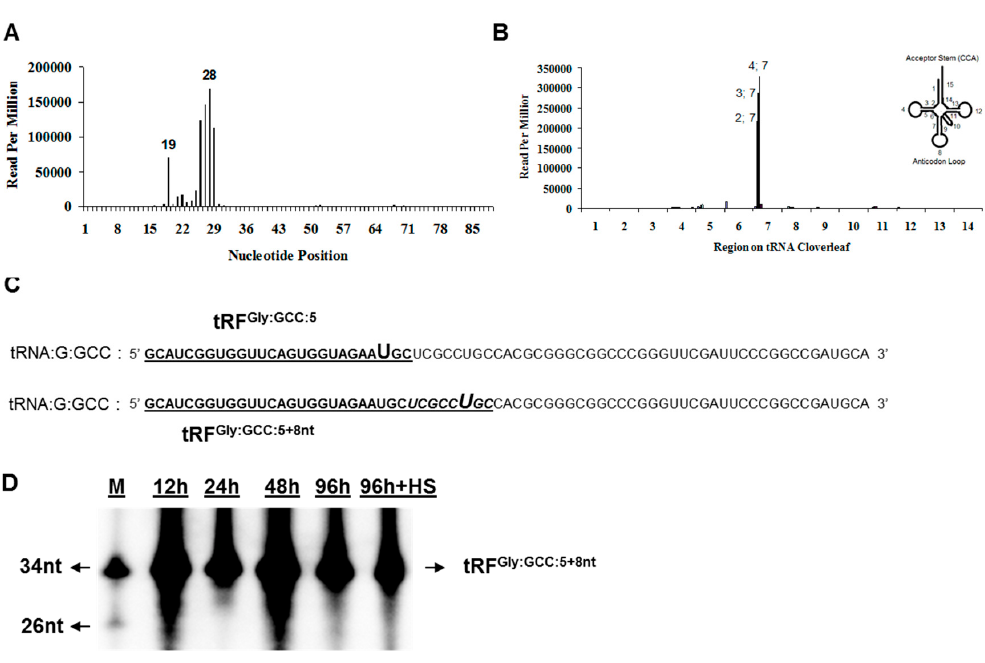
Figure 4. Three-foot-end-extended tRFs are not trimmed in S2 cells in the absence or presence of heat shock. ( A ) Three-foot-end cleavage site is relative to the 5’-end of tRNAs. All tRFs were aligned to the tRNA they originated from and 3’ cleavage site was determined relative to the 5’ end. The relative cloning frequency (read-per-million) was superimposed on a representative tRNA; ( B ) Each tRNA was divided into 15 main coordinates shown on a typical cloverleaf structure on the upper right corner. Each tRNA was folded using tRNAScan-SE [31] and the position of the 3’-end cleavage site was determined relative to each of the 15 coordinates. Normalized read-per-million cloning frequency of each fragment was plotted against the 15 positions. Nucleotide position is shown followed by the coordinate on the tRNA coverleaf (2;7 representing second nt on the 7th coordinate) ( C ) Nucleotide sequence of tRNA Gly:GCC . The sequence of tRF Gly:GCC:5 and tRF Gly:GCC:5+8nt (which contains an 8-nt extension) are underlined. The 8-nt extended sequence is italicized. The biotinylated U residues are